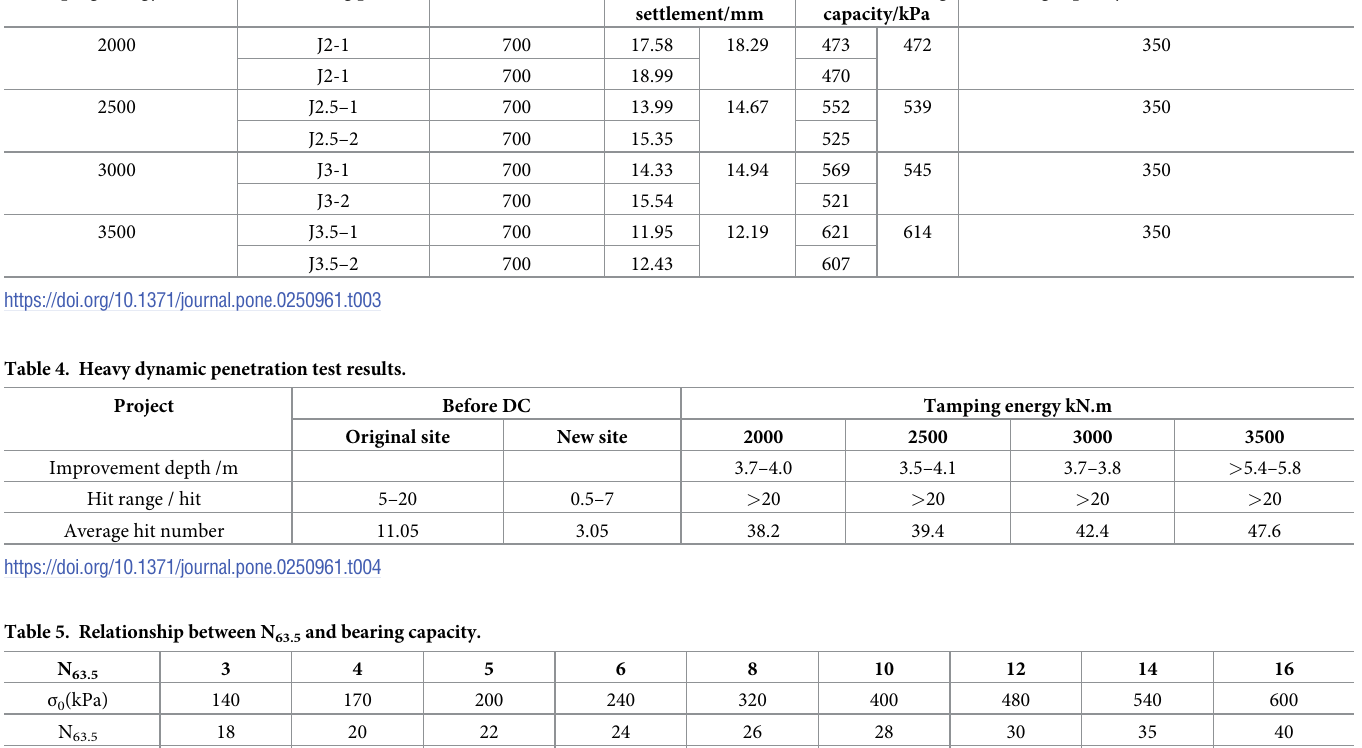
Table 3. Bearing capacity and characteristic values of the coal gangue site treated by the DC method. Tamping energy kN.m